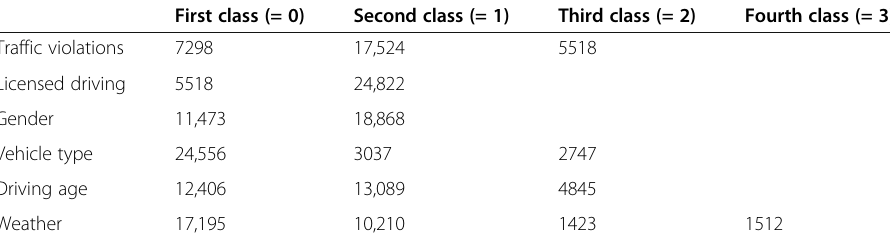
Table 1 Descriptive statistics of data